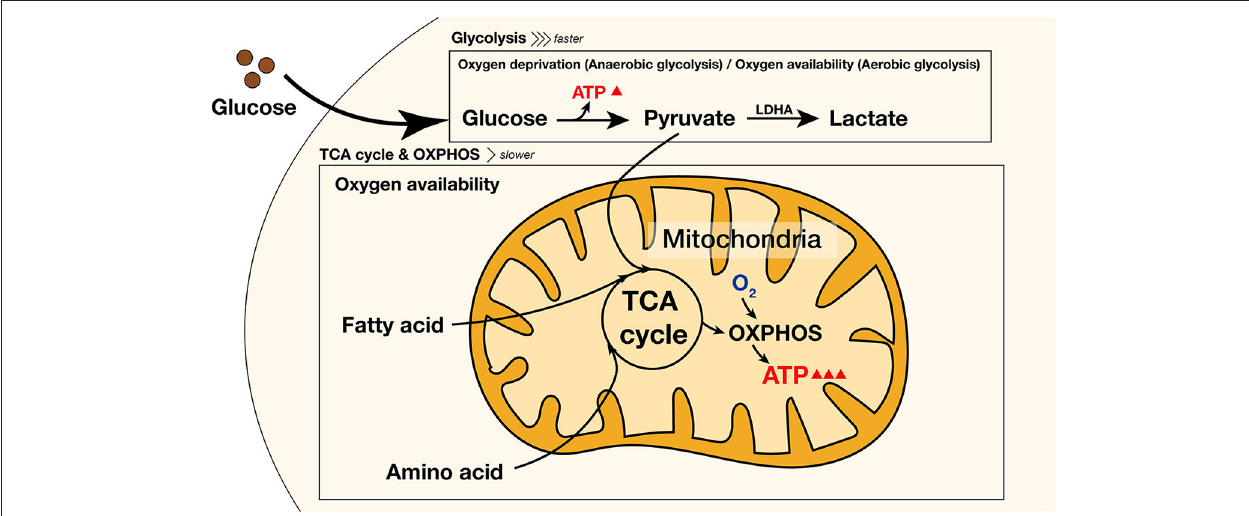
FIGURE 1 | Pathways of intracellular energy metabolism during differentiation and reprogramming. In glucose metabolism, ATP is generated via aerobic/anaerobic glycolysis or OXPHOS that requires O 2 . Glycolysis generates ATP faster than OXPHOS, whereas OXPHOS slowly generates much more ATP than glycolysis. Amino acids and fatty acids fuel the TCA cycle and enhance the OXPHOS pathway to generate additional ATP. ATP, adenosine triphosphate; LDHA, lactate dehydrogenase A; TCA, tricarboxylic acid; OXPHOS, oxygen phosphorylation; O 2 ,